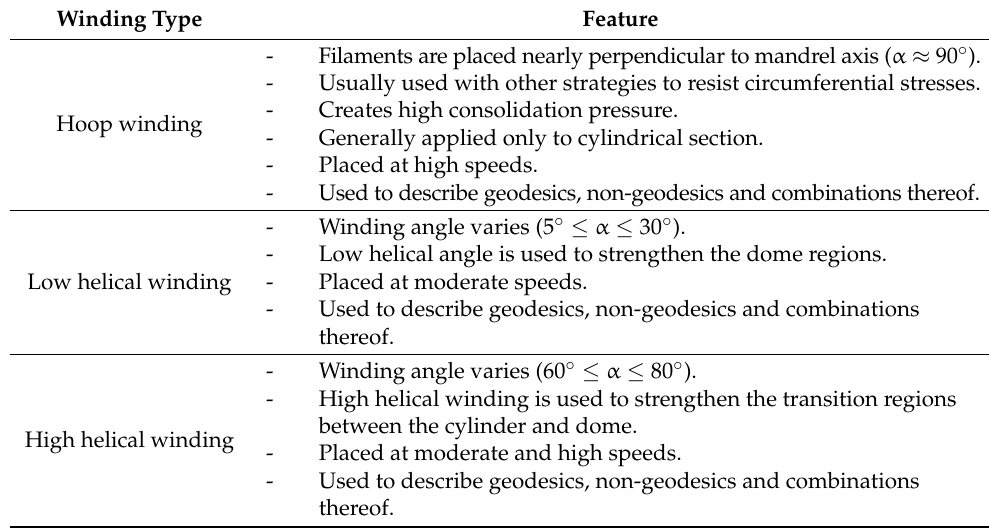
Table 7. Main feature of different filament winding